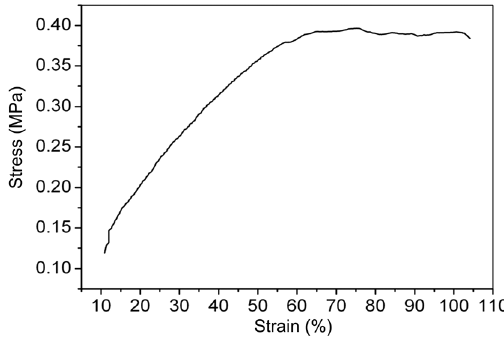
Figure 4 Stress-strain plot of the polymer matrix with a speed of 50 mm min -1 .